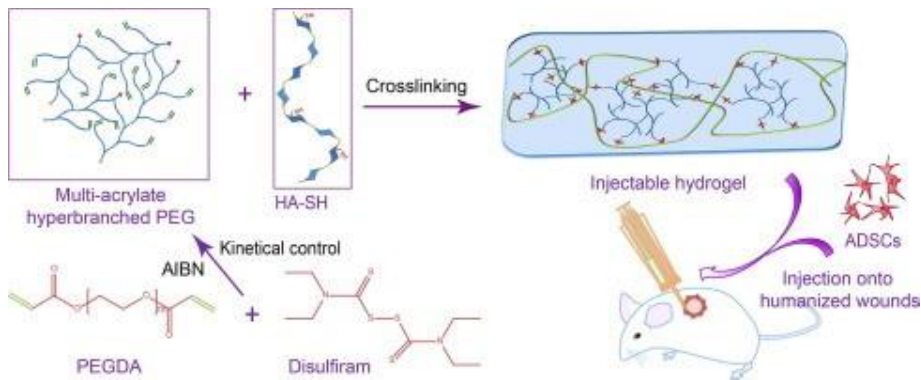
Figure 8. Schematic presentation of encapsulated adipose-derived stem cells (ADSCs) by an injectable hybrid hydrogel. Reproduced from [143] with permission. Copyright 2018 Acta Materialia Inc. Published by Elsevier Ltd. All rights reserved.